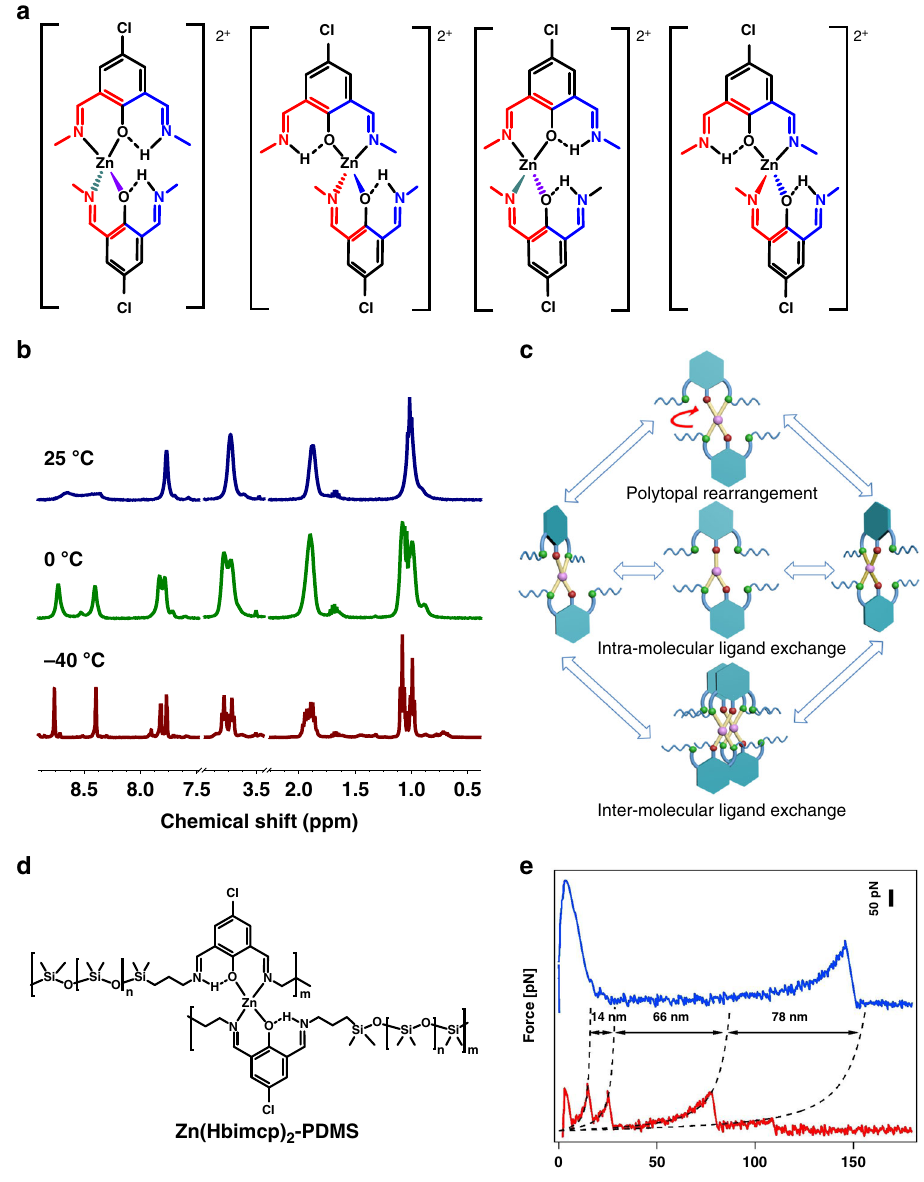
Fig. 1 Structure and characterization of model complex and polymer. a Possible stereochemical structures for [Zn(Hbimcp) 2 ] 2 + complex. b Variable temperature 1 H nuclear magnetic resonance (NMR) for Zn(Pr-Hbimcp)Cl 2 . c Three possible pathways for ligand exchange process. d The structure of polymer complex Zn(Hbimcp) 2 -PDMS . e Typical force – extension curves during force spectroscopy measurements of the stretching of a single chain of Hbimcp-PDMS (blue line) and of Zn(Hbimcp) 2 -PDMS (red line). Scale bar for the vertical axis, 50